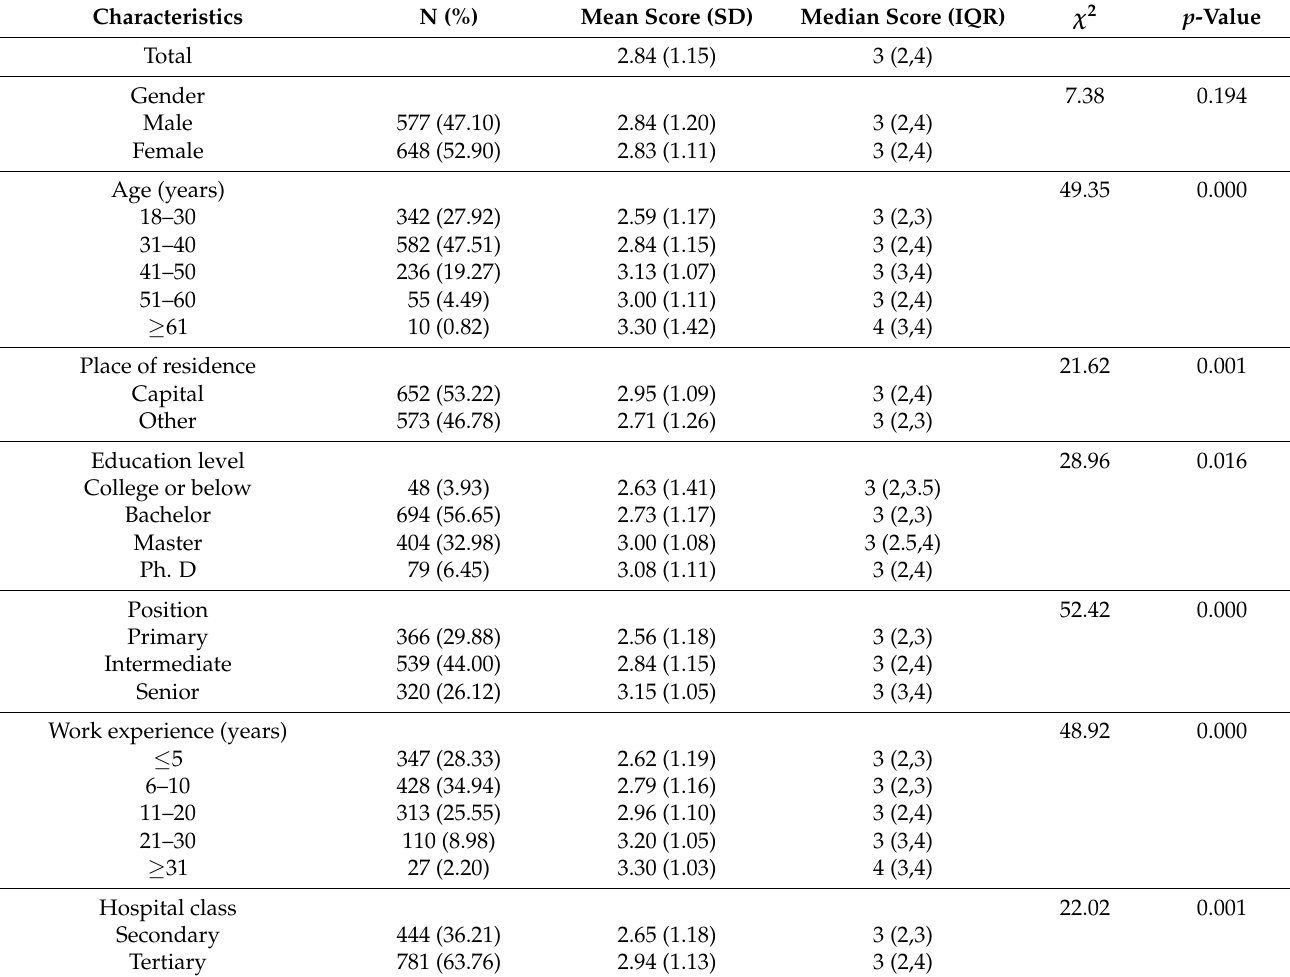
Table 1. Demographic characteristics of physicians and their knowledge